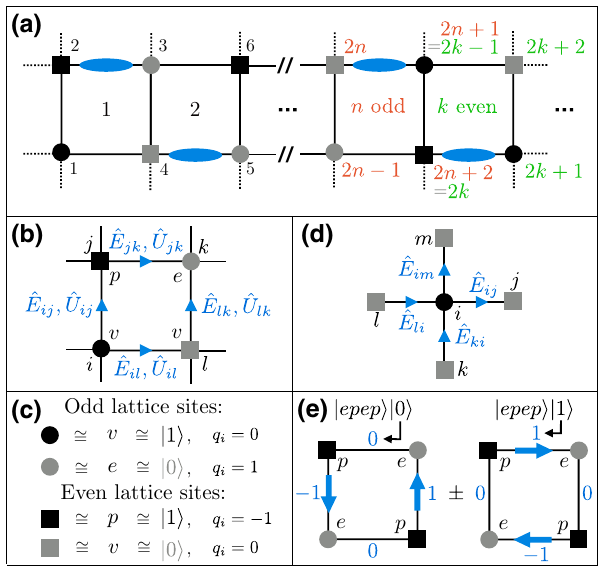
FIG. 2. Conventions for lattice QED in 2D. (a) The ladder system with open boundary conditions. Using Gauss’s law, the number of gauge degrees of freedom can be reduced to one per plaquette (blue ellipses). (b) A single plaquette with matter sites at the vertices and gauge fields on the links. The circles (squares) represent odd (even) sites and black (gray) corresponds to unoc- cupied (occupied) fermionic fields. The positive field direction is to the right and up. (c) A table showing the mapping between fermionic sites, particles ( e ) and antiparticles ( p ), and spins. (d) The conventions for Gauss’s law. (e) The two gauge-field con- figurations that minimize the electric field energy for a single plaquette with two particle-antiparticle pairs. As explained in the main text, these configurations are relevant for the 2D effects discussed in Sec. V A (for more details, see Appendix